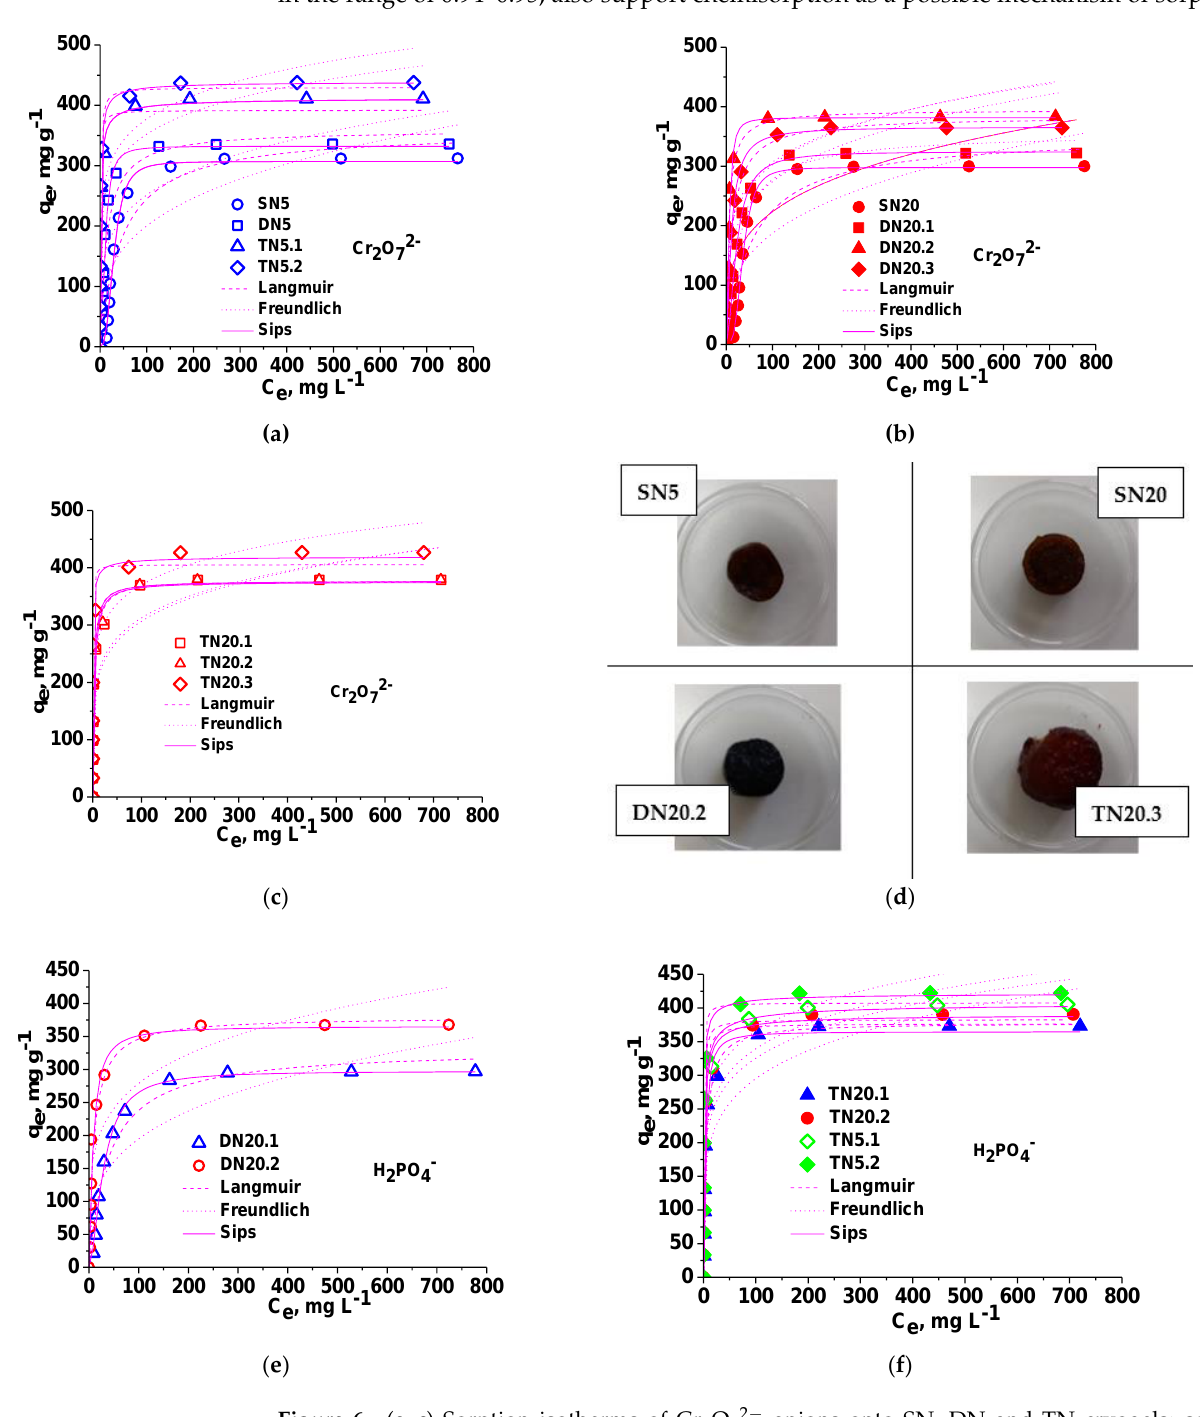
Figure 6. ( a – c ) Sorption isotherms of Cr 2 O 72 − anions onto SN, DN and TN cryogels; sorbent dose = 0.0075 mg; V sol = 10 mL; temp. = 23 °C; pH = 3 for SN and DN, and pH = 4 for TN; contact time = 24 h. ( d ) Optical images of some cryogels after their loading with Cr(VI). Sorption isotherms toward H 2 PO 4 − onto DN ( e ) and TN ( f ) composite cryogels. The sorption kinetics of H 2 PO 4 − anions onto the novel multi-network cationic sorbents (DN20.1, DN20.2, TN20.1, TN20.2 and TN5.1; Table S8) confirm the previous